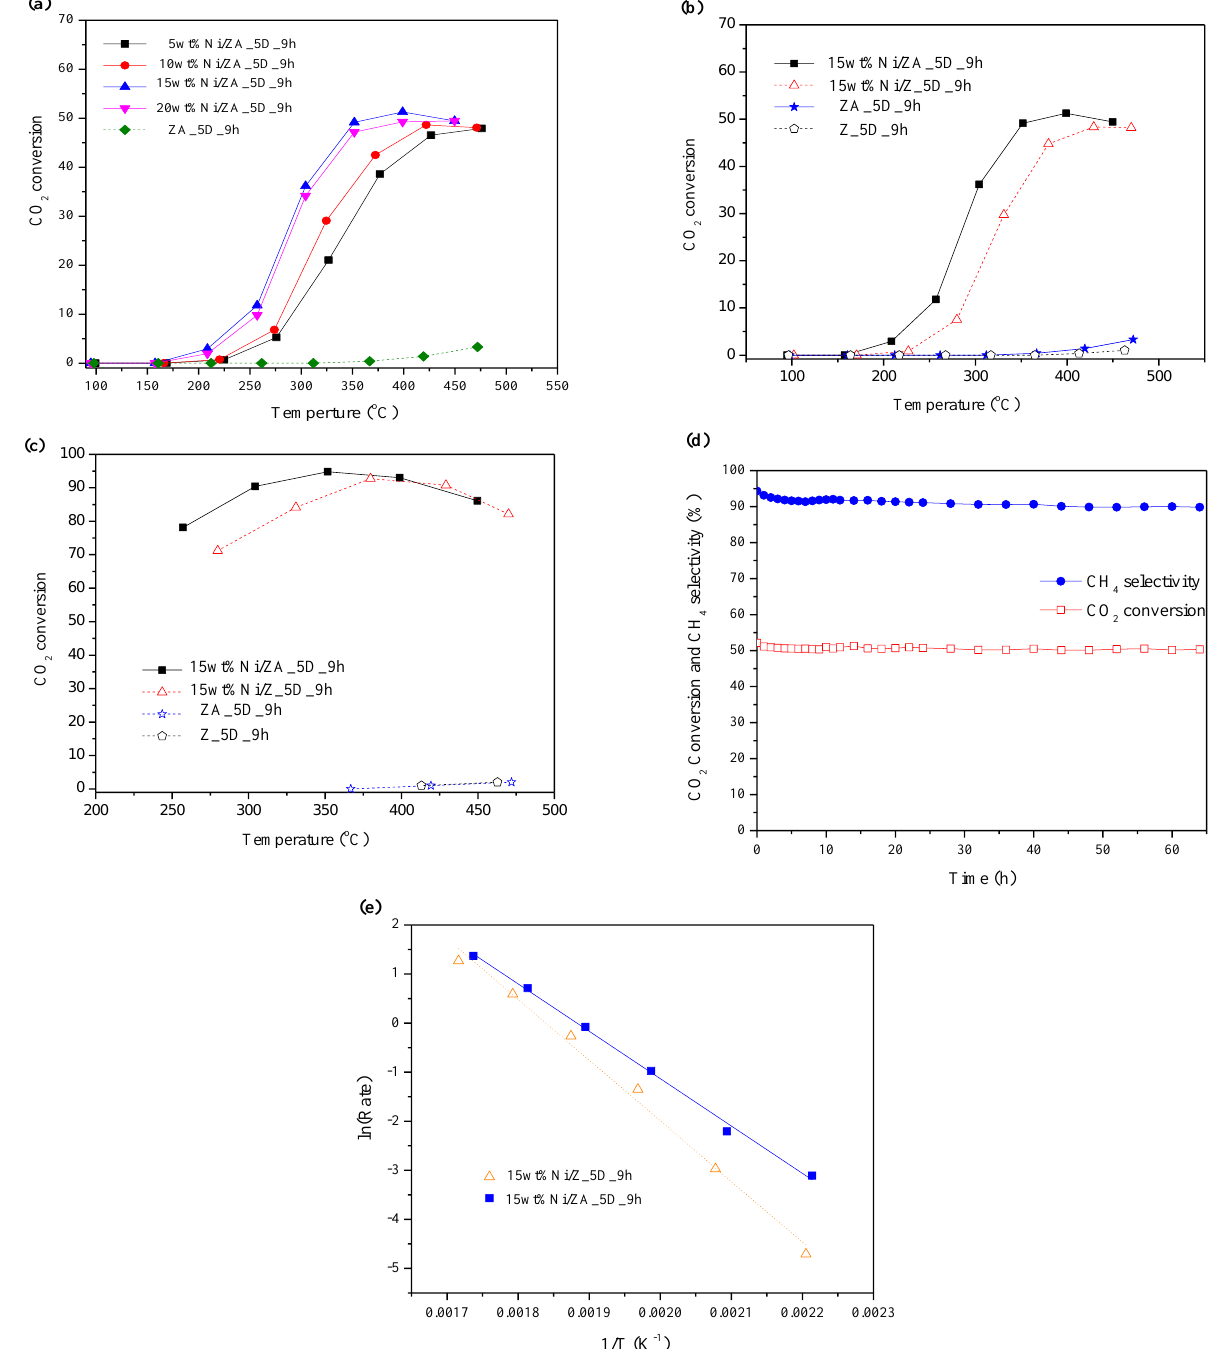
Figure 5. CO 2 methanation catalytic activities of ( a ) 5, 10, 15, and 20wt%Ni/ZA_5D_9h; ( b ) 15wt%Ni/ZA_5D_9h, 15wt%Ni/Z_5D_9h, ZA_5D_9h, and Z_5D_9h; ( c ) CH 4 selectivity of 15wt%Ni/ZA_5D_9h, 15wt%Ni/Z_5D_9h, ZA_5D_9h, and Z_5D_9h; ( d ) stability of 15wt%Ni/ZA_5D_9h at 400 °C for 70 h; and ( e ) Arrhenius plot of 15wt%Ni/Z_5D_9h, 5, and 15wt%Ni/ZA_5D_9h.